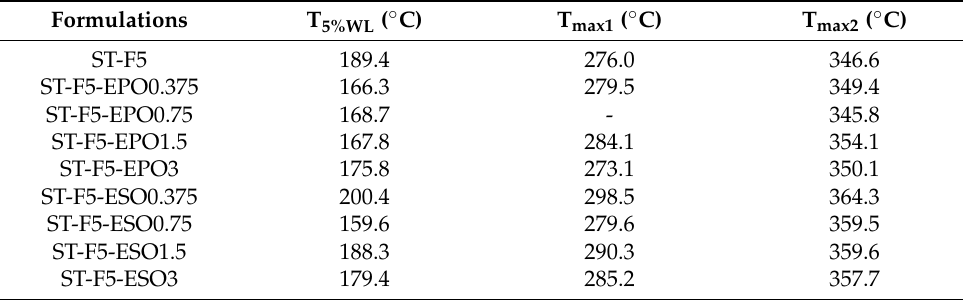
Table 3. Thermal degradation parameters of the prepared bioplastic composites.